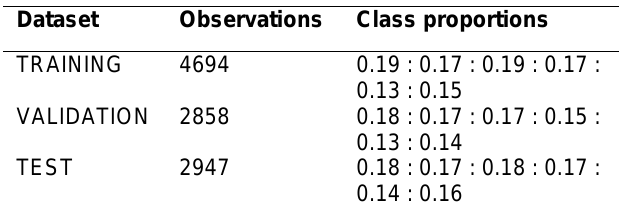
Table 1. Number and class proportions of observations used for training, validation and test.